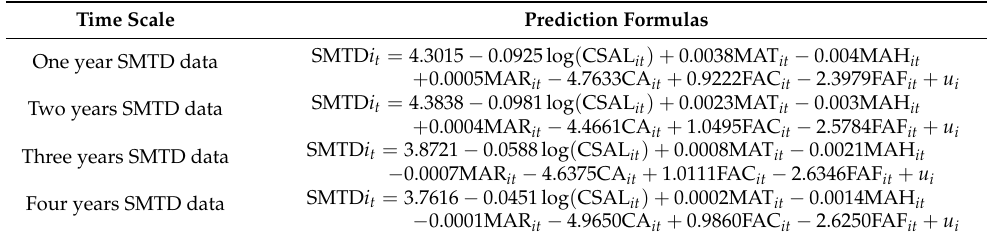
Table 8. Prediction formulas of random-effects model using different time scales of SMTD data.